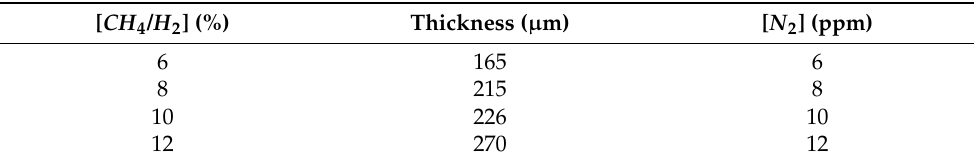
Table 2. Thickness measurements for each CH 4 and N 2 from feed gases